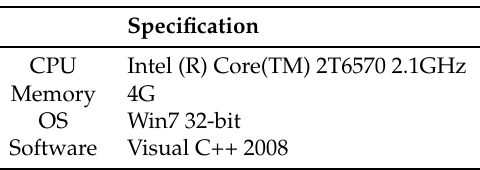
Table 6. Hardware and Software